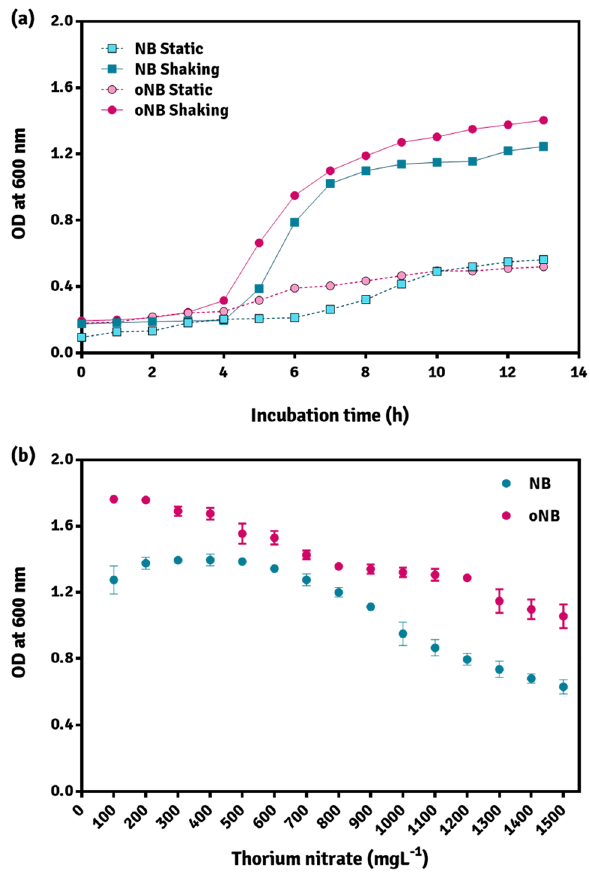
Figure 5. ( a ) Comparison of growth of P. thoriotolerans sp. nov. AM3 on NB and optNB in static and shaking conditions ( b ) Tolerance to thorium nitrate by AM3. *OD 1 corresponds to 10 9 CFU/mL of P. thoriotolerans sp. nov. AM3 (image created in GraphPad Prism 6).